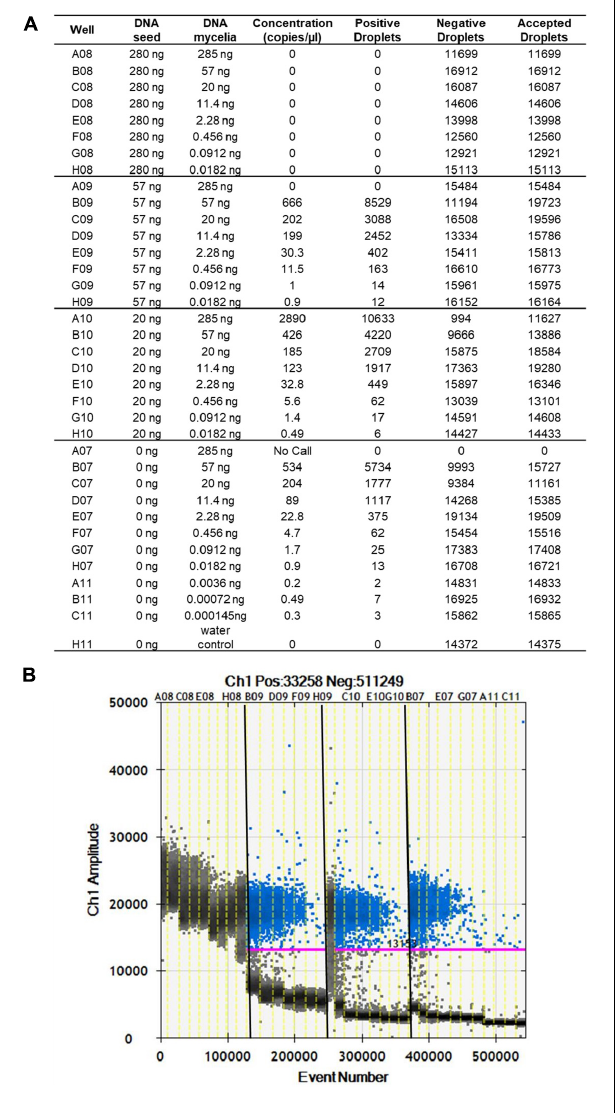
the healthy seeds sample (IHS), no amplifications were recorded ( Figures 3A,B